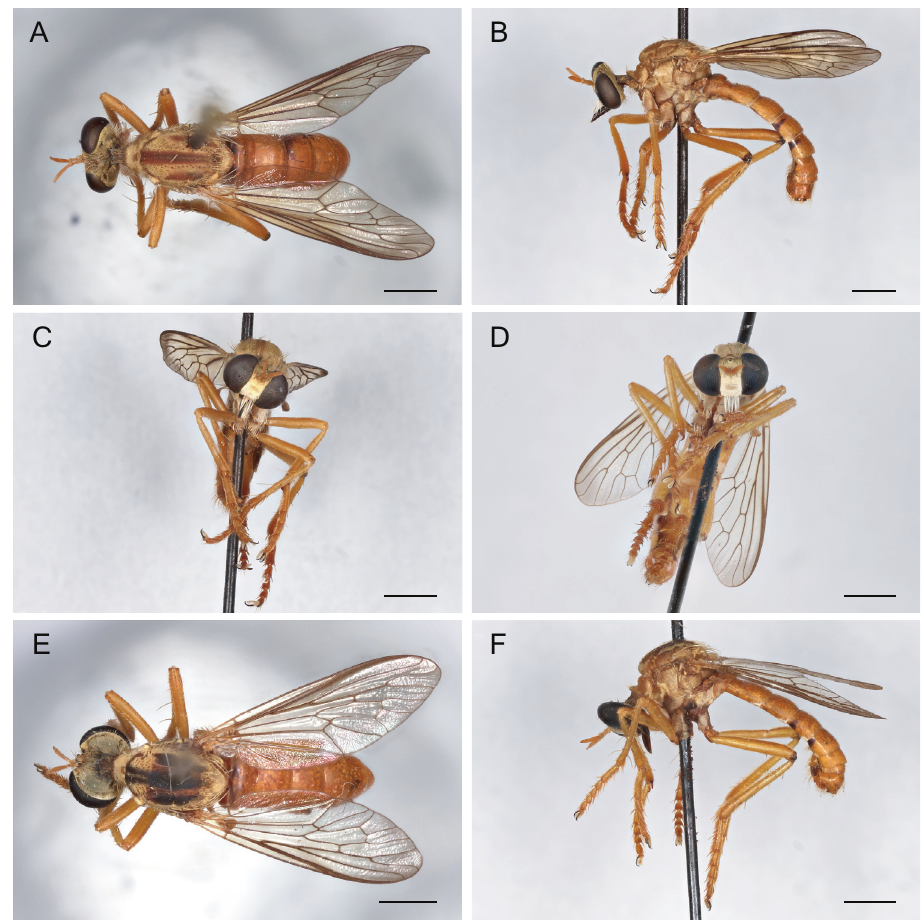
Figure 30. Saropogon solus Bromley, 1951 Female (USNMENT01819178): A dorsal view B lateral view C anterior view; Male (USNMENT01819132): D anterior view E dorsal view F lateral view. Scale bars 2